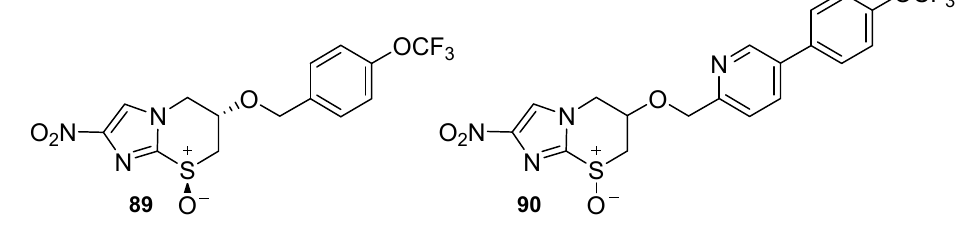
Figure 21. New leads to treat African trypanosomiasis.